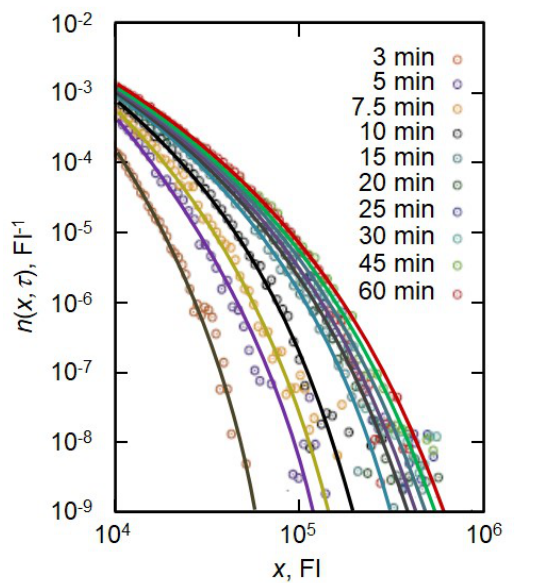
Figure 3. The unsteady-state density distribution functions n ( x , τ ) at different times accordingly to an analytical solution (37) (lines) and experimental data [10] (symbols). System parameters correspond to Figure 1 and J = 546 FI s − 1 , b (cid:48) at τ 0 = 3